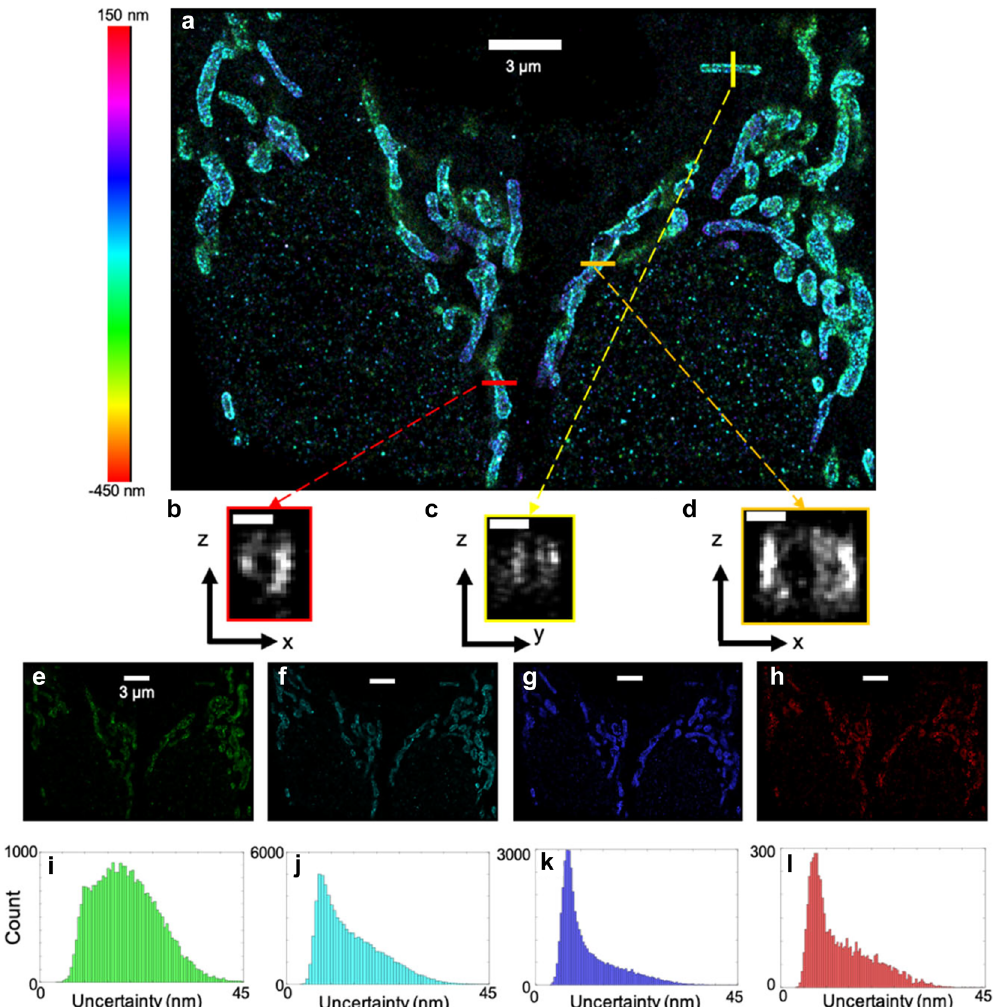
Figure 5: Demonstration of 3D single-color DWP imaging. (a) 2D projection of a 3D mitochondria image color-coded with respect to z -position. The pseudocolor spectrum ranges from magenta to red and represents a 600 nm range. (b – d) Cross-sections of the mitochondria from the three positions in the panel (a) highlighted by the red, yellow, and orange lines, respectively. The scale bar is 300 nm (e – h) 2D projections of four 50-nm thick slices of mitochondria and (i – l) the corresponding histograms of the lateral localization uncertainties estimated using Thunderstorm. Slices correspond to − 255: − 205 nm (e, i), − 135: − 85 nm (f, j), − 35:15 nm (g, k), and 65 – 115 nm (h, l), respectively. The size of inset boxes in (a) are exaggerated for better